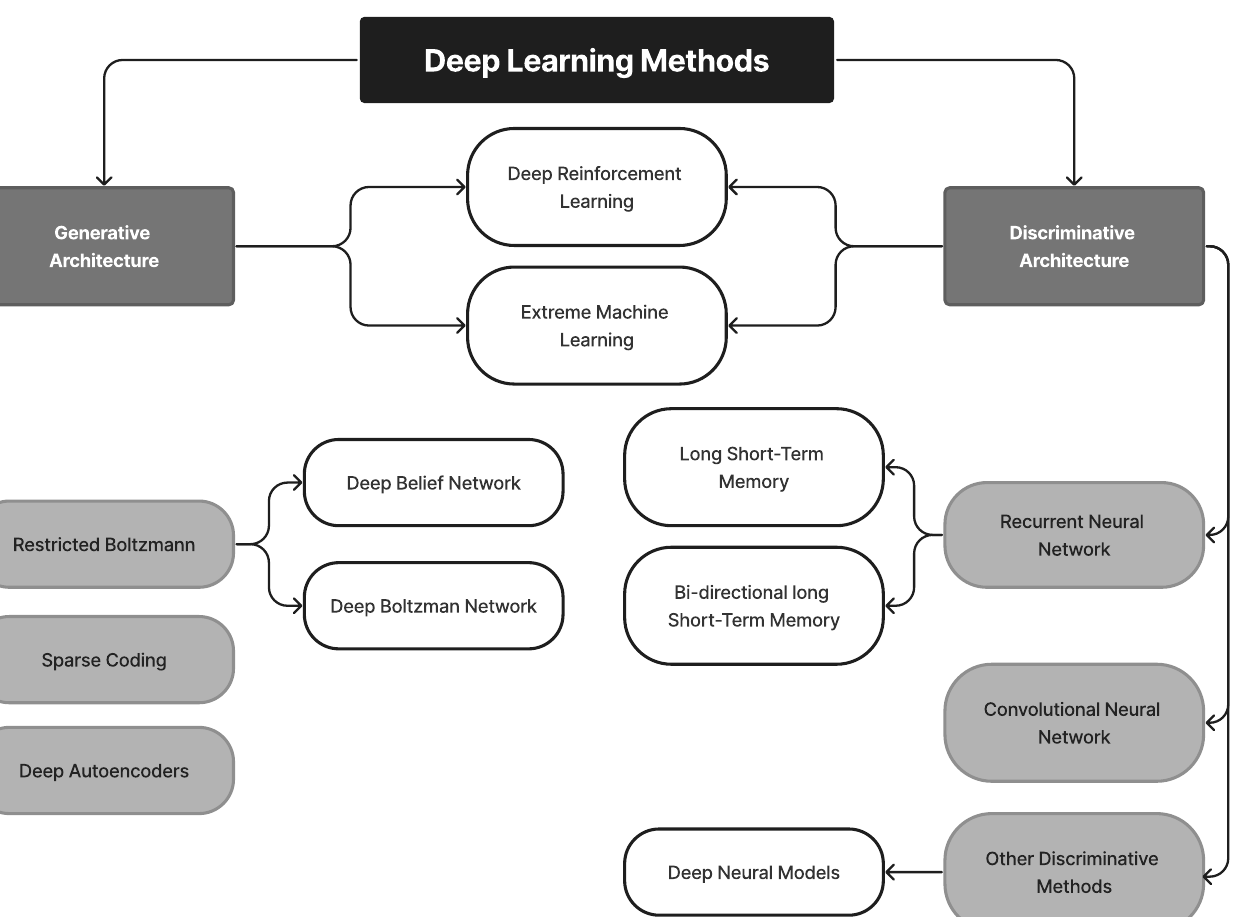
Figure 10. DL Models for Oral Cancer Diagnosis used in this review .